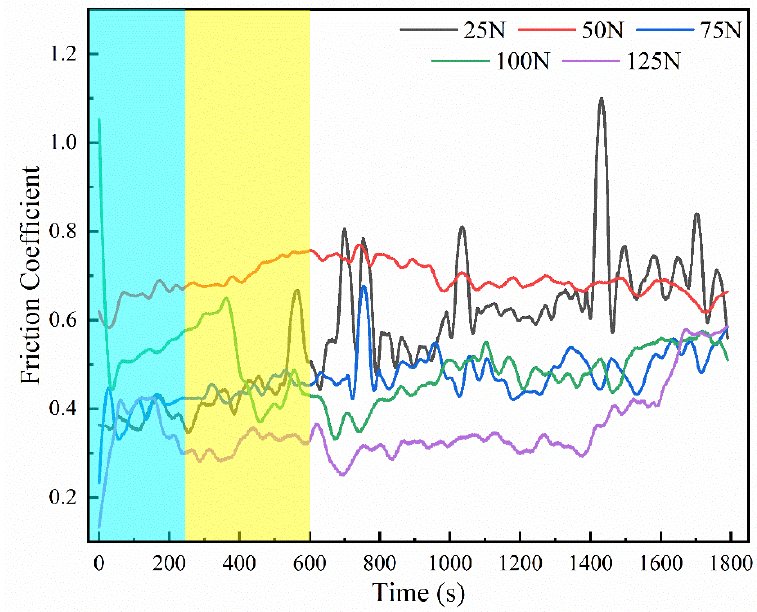
Figure 11. The curve of the friction coefficient of sample YG8-20 over time under various loads.